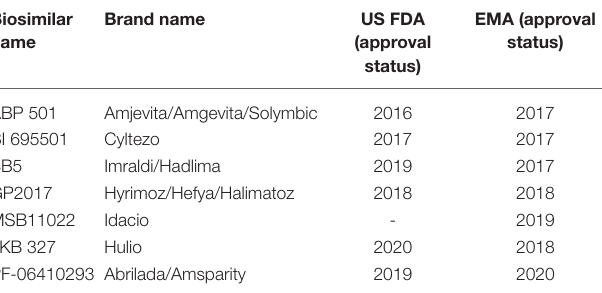
TABLE 1 | Approval status of adalimumab